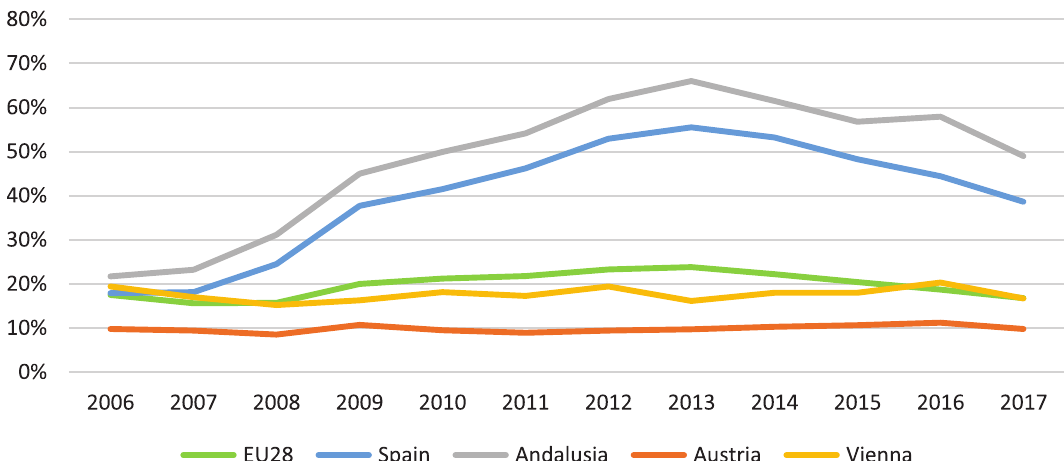
Figure 1. Youth unemployment rates, age group 15–24 years. Source: developed by the authors with Eurostat (2019) data.